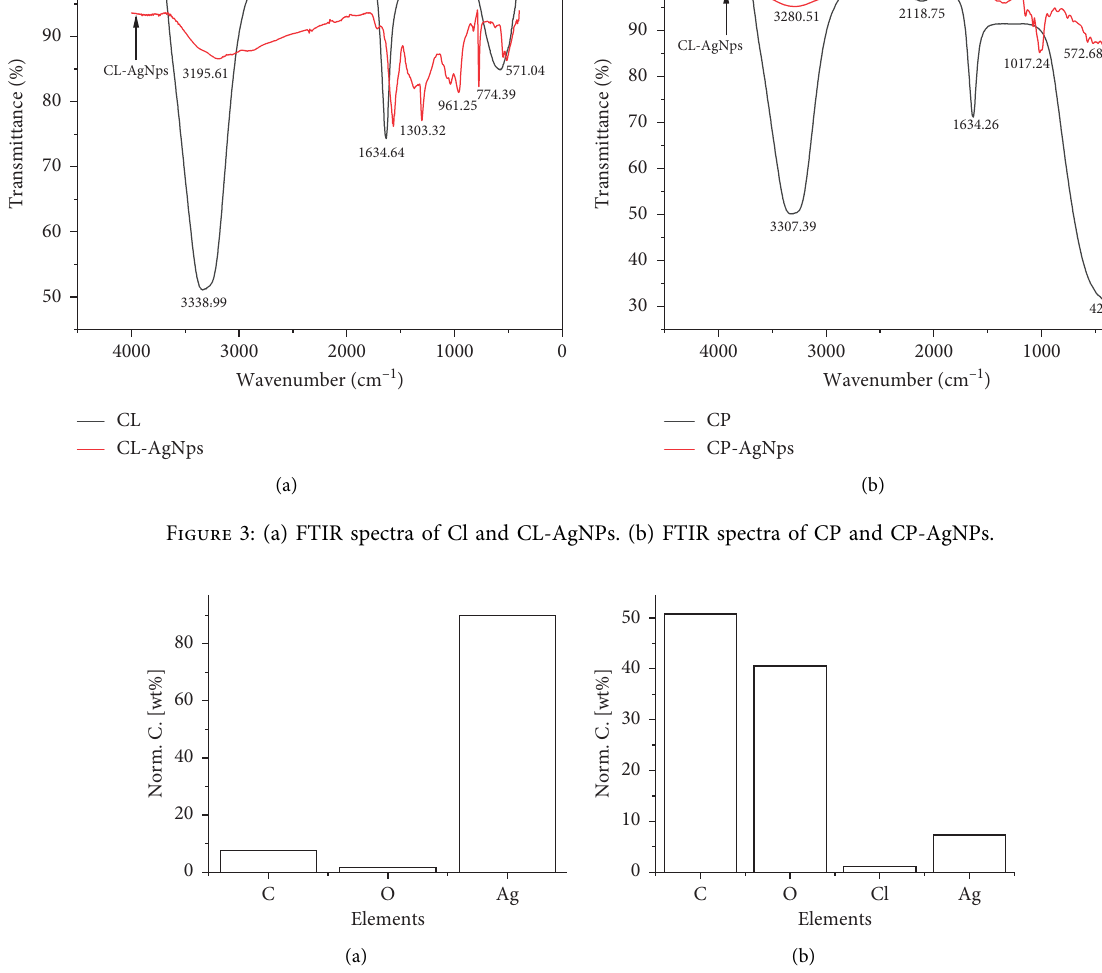
Figure 4: (a) EDX analysis of CL-AgNPs. (b) EDX analysis of